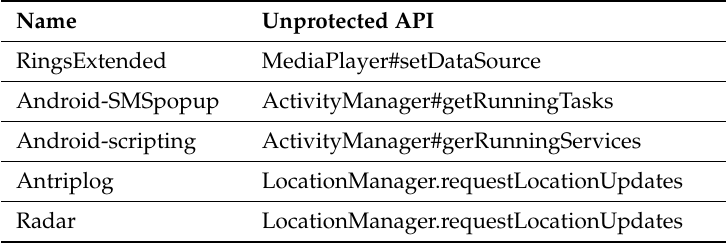
Table 4. Examples of open-source apps with unprotected API methods.